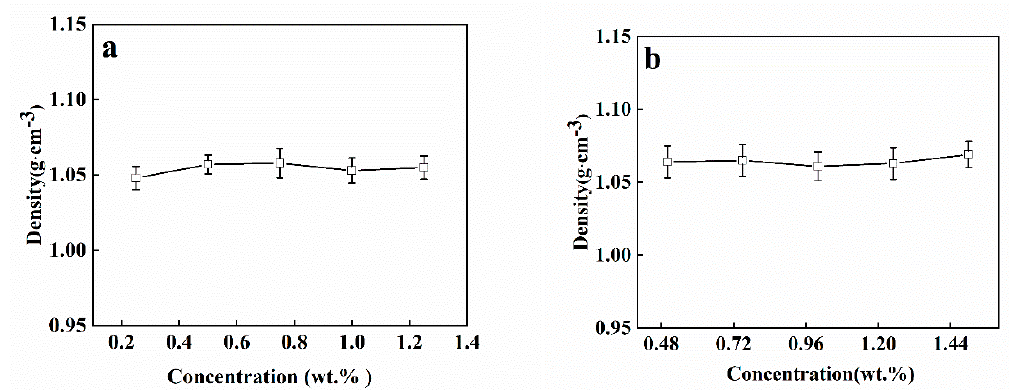
Figure 4. The density of ( a ) SA solutions at concentrations of 0.25, 0.5, 0.75, 1.0 and 1.25 wt.% and ( b ) CaCl 2 /CMC solutions at CMC’s concentrations of 0.5, 0.75, 1.0, 1.25 and 1.5 wt.%.